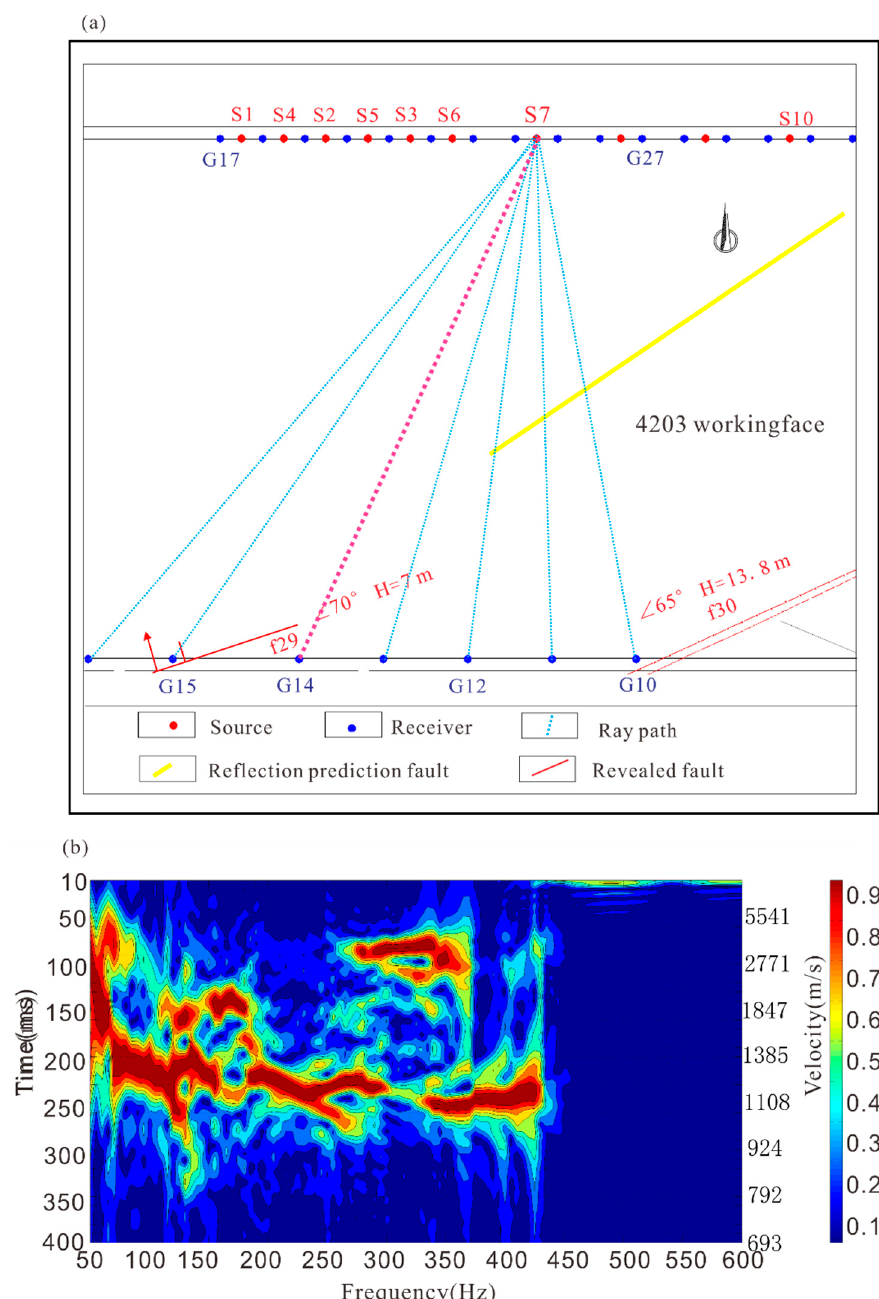
Figure 7. ( a ) S7-14 ray path; ( b ) S7-14 dispersion map for an unknown reflective fault Table 1. Prediction results of logistic regression and neural network.